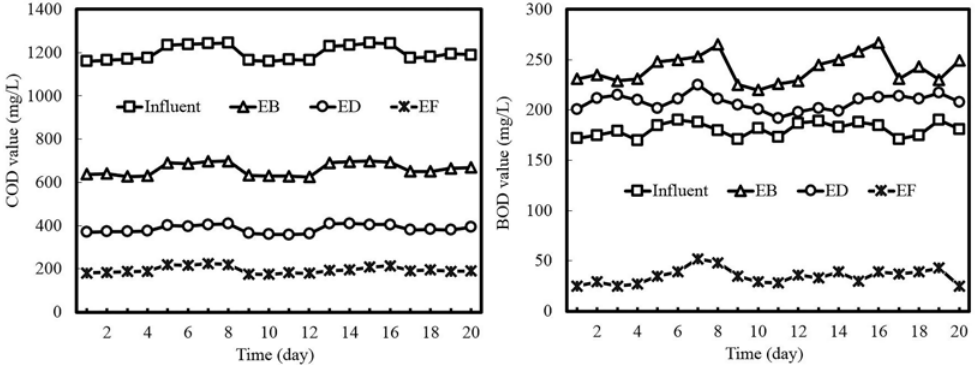
Figure 6. Variations of BOD and COD versus time in different tanks with an HRT of 8 h. Table 3. The average COD, BOD, and SS concentrations in different tanks and removal efficiency with an HRT of 8 h.